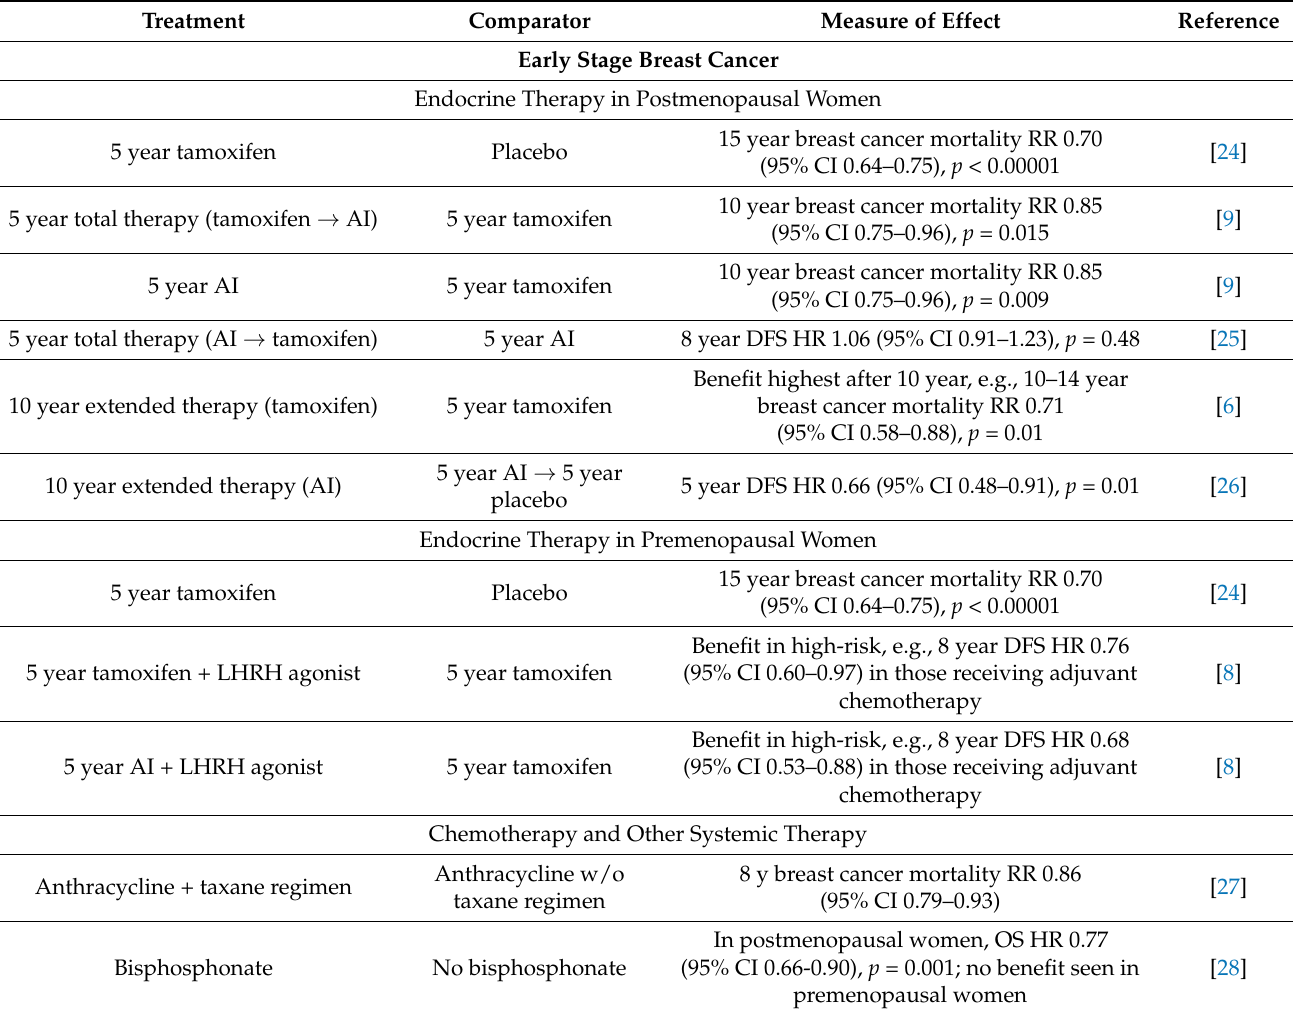
Table 1. Summary of current treatment strategies for hormone receptor-positive (HR+) breast cancer.